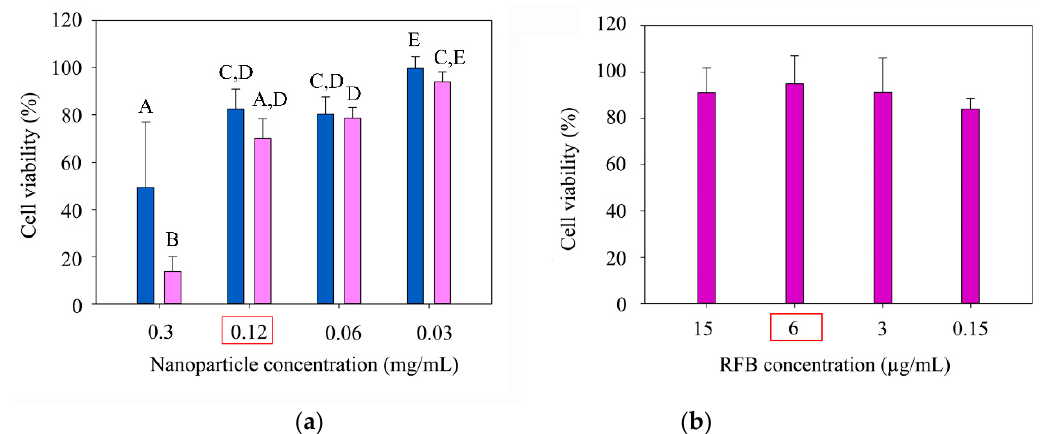
Figure 5. Cell viability (%) relative to control with Milli-Q ® water of ( a ) blank NLC formulations (dark blue colour) and RFB-loaded formulations (pink colour), using several nanoparticle concentrations (0.3, 0.12, 0.06 and 0.03 mg / mL). ( b ) Cell viability (%) relative to control with DMSO, of RFB solutions in DMSO prepared employing the same drug concentration as present in NLC formulations (purple colour). (A–E characters denote the homogeneous subsets pointed out by the post hoc Tukey’s Multiple Comparison Test ( p < 0.05).